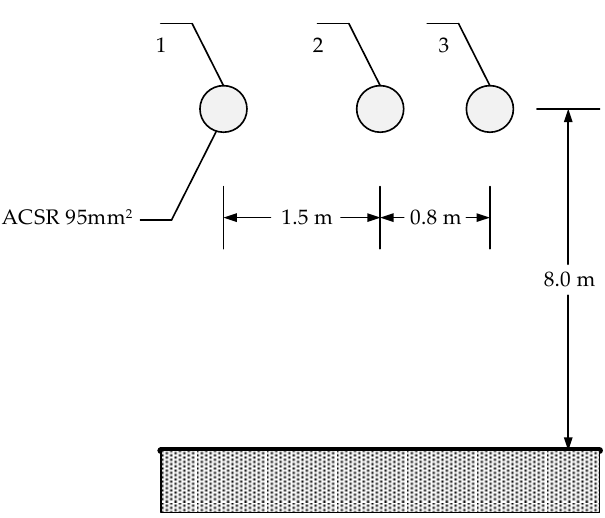
Figure 2. Overhead line (OHL) configuration.